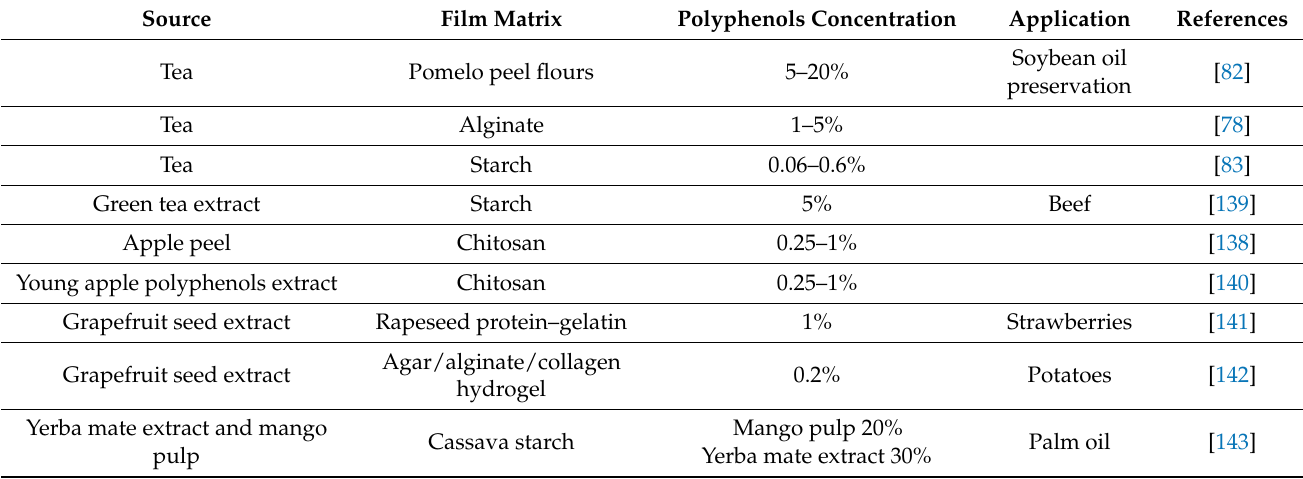
Table 1. Applications of biodegradable films incorporating polyphenols, used as food